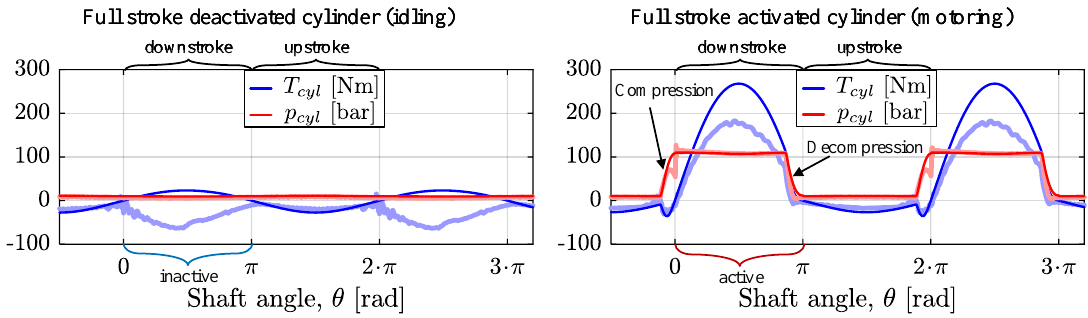
Figure 13. Experimental and simulation results for idling and full stroke motor operation (light color is experimental results, and dark color is simulation